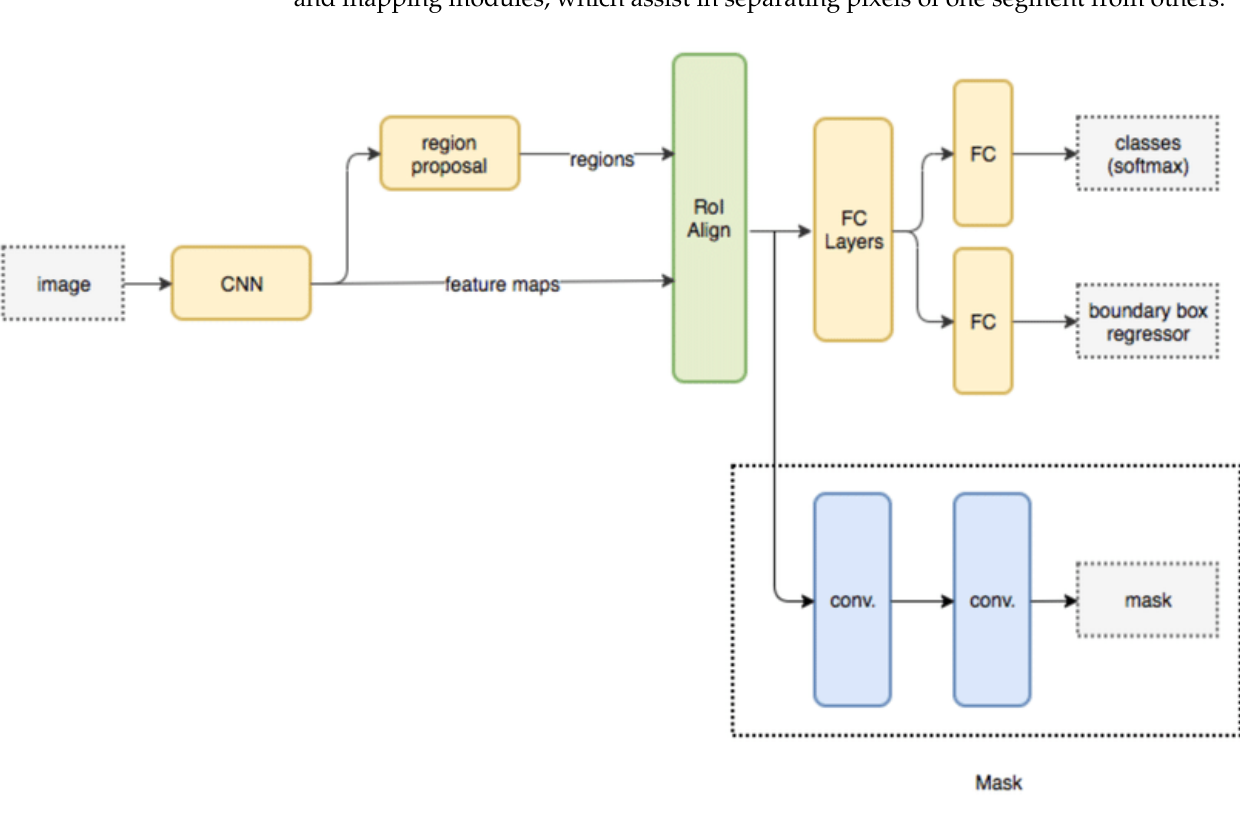
Figure 4. Masked Region CNN model for pixel-level classi fi cation for segment extraction.